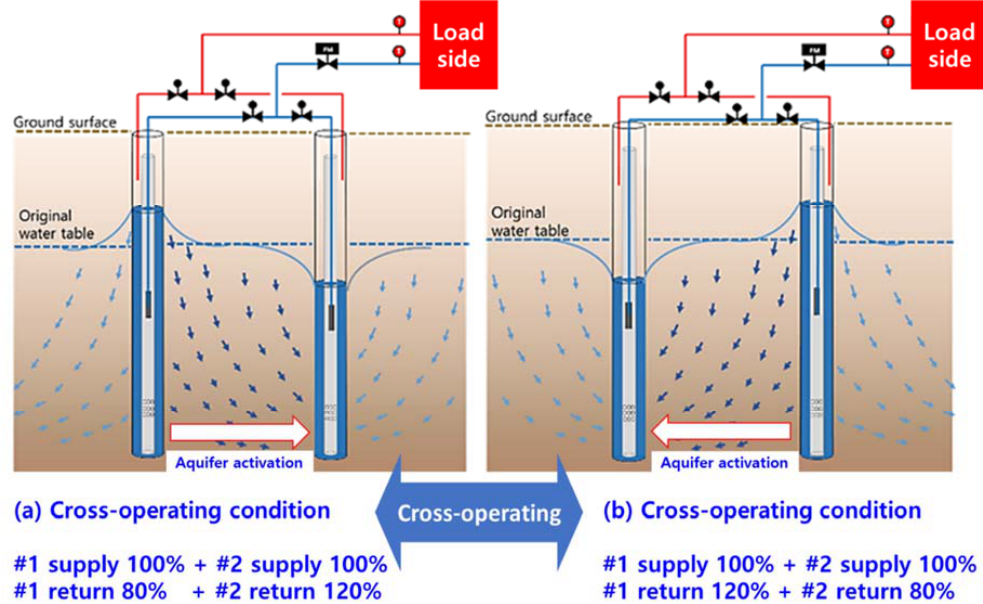
Figure 2. Cross operation of the balancing well geothermal heat exchanger system.